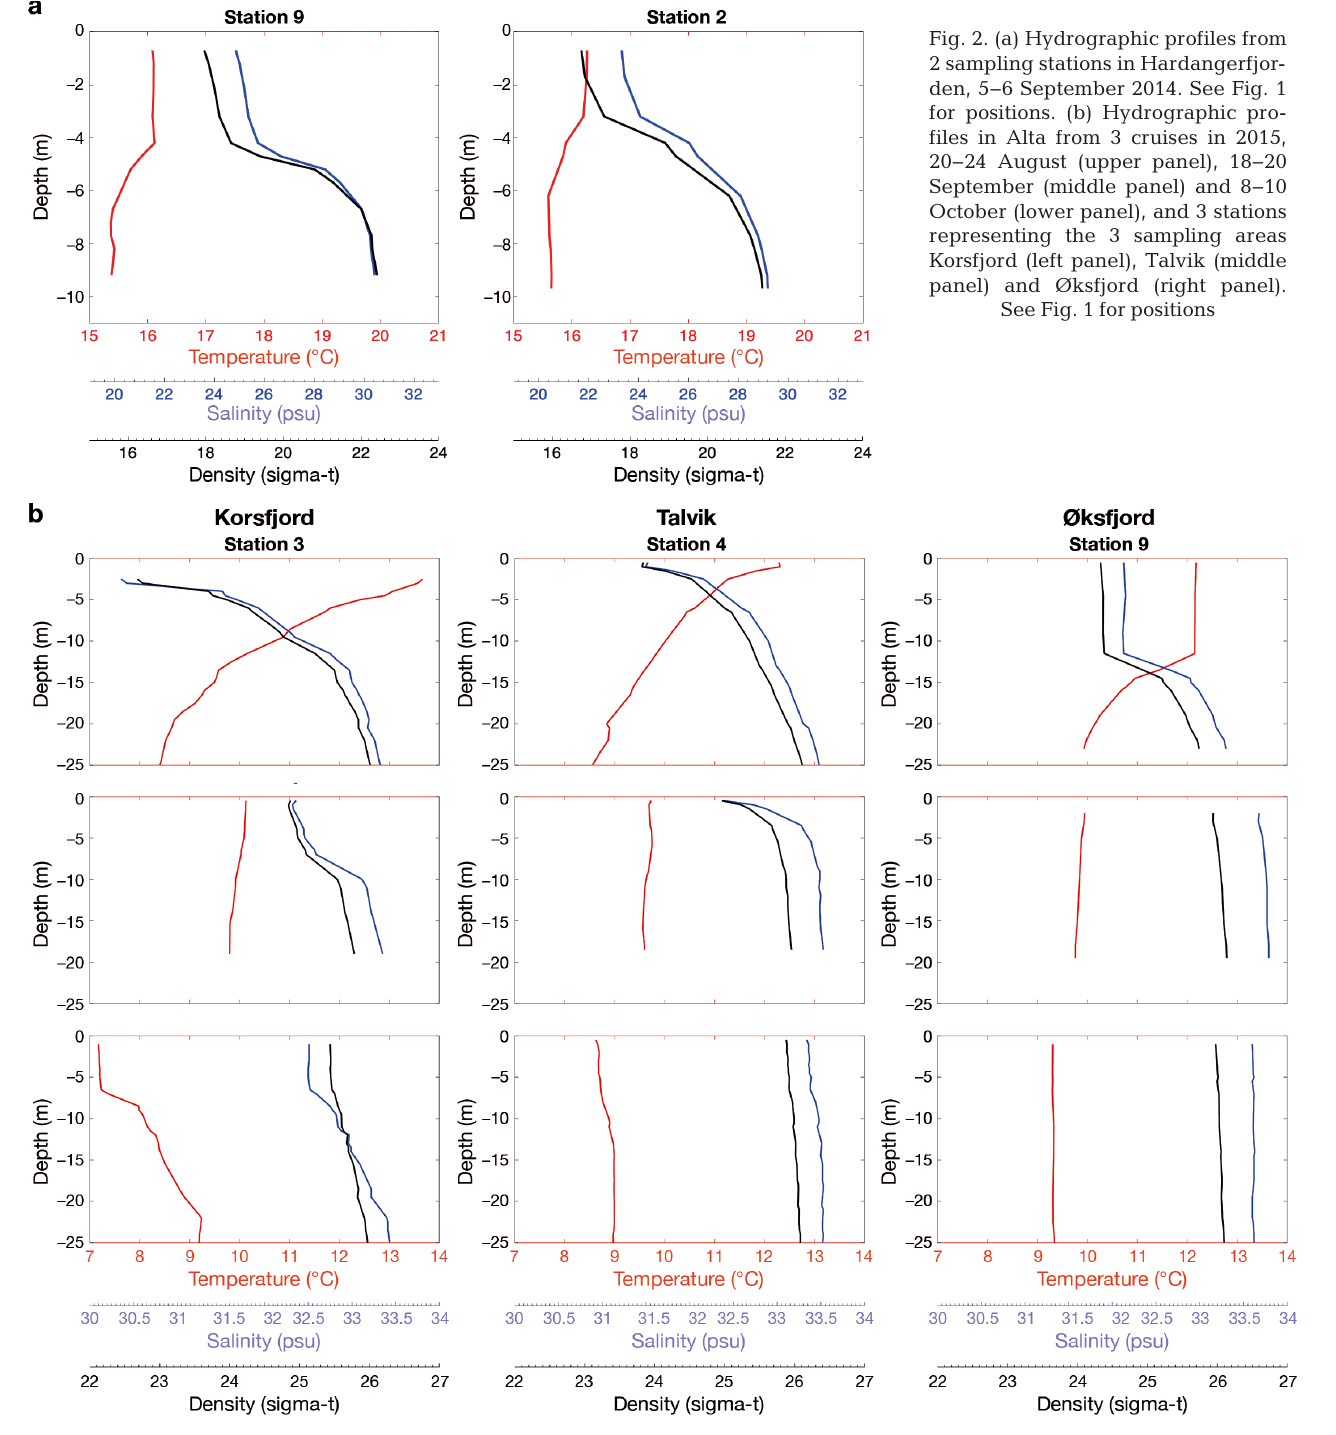
Fig. 2. (a) Hydrographic profiles from 2 sampling stations in Hardangerfjor- den, 5−6 September 2014. See Fig. 1 for positions. (b) Hydrographic pro- files in Alta from 3 cruises in 2015, 20−24 August (upper panel), 18−20 September (middle panel) and 8−10 October (lower panel), and 3 stations representing the 3 sampling areas Korsfjord (left panel), Talvik (middle panel) and Øksfjord (right panel). See Fig. 1 for